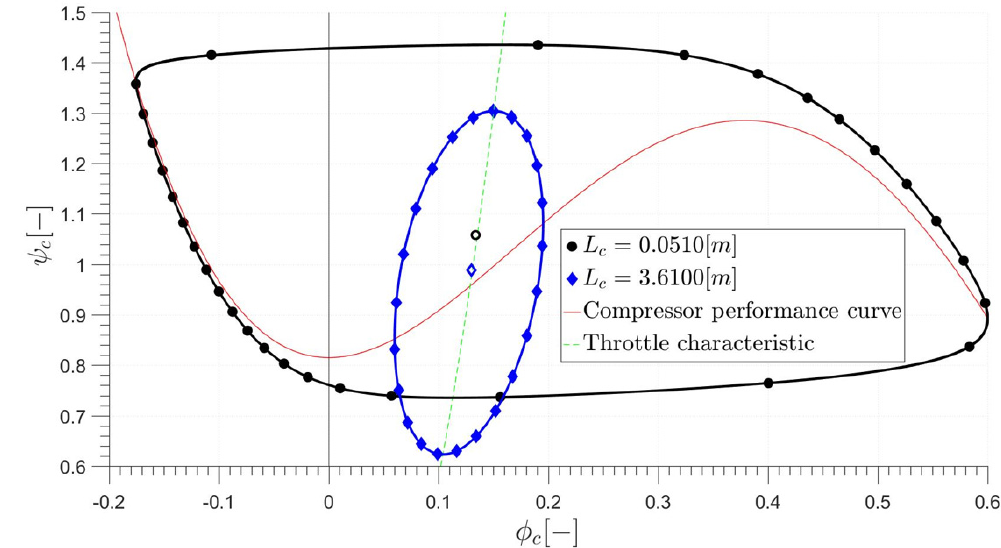
Figure 8. Simulated surge limit cycles using two different values of L c parameter for mass flow (cid:2038) (cid:2913) = 0.116.